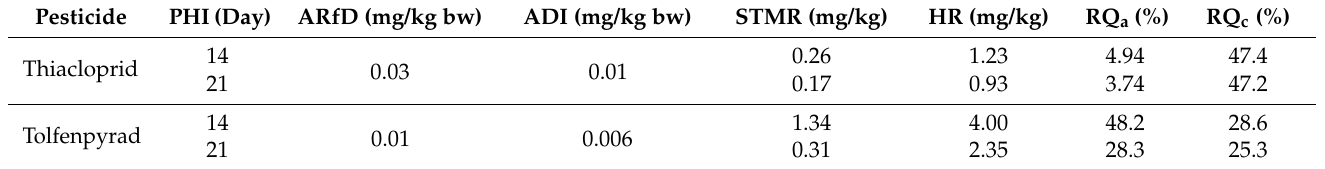
Table 5. Dietary risk assessment of thiacloprid and tolfenpyrad in tea at two different